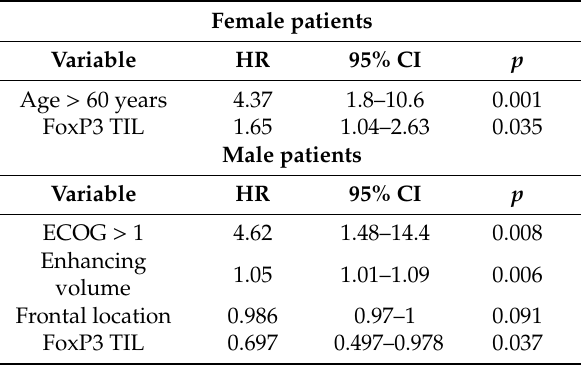
Figure 3. Selected Kaplan–Meier survival plots for variables with differential prognostic associations in female (upper row) and male patients (lower row). ( A ) In female patients, CD45ro+ TIL were associated with a worse survival (mOS 5.3 vs. 18.2 months, p = 0.027). ( B ) In contrast, there is no significant association in male patients (mOS 37.7 vs. 9.95 months, p = 0.25). ( C ) In female patients, FoxP3+ TILs are associated with worse survival (mOS 9.6 months vs. mOS not reached, p = 0.049), whereas in males ( D ) there is no association (mOS 49.6 vs. 11.8 months, p = 0.16). ( E ) While increased enhancing tumor volume does not affect survival in females (mOS 16.8 vs. 7.1 months, p = 0.23), male patients ( F ) with an increased contrast enhancement show a non-significant tendency towards worse outcomes (6.92 vs. 37.7 months, p = 0.09). ( G ) Cluster membership was associated with survival in female patients (mOS 3.9 vs. 18.2 vs. 82.9 months, p = 0.005, ( H ) but not in male patients (37.7 vs. 11.8 months, p = 0.17). Table 2. Cox regression modelling performed separately for female and male patients. Hazard ratios for numerical variables are given as per percentage point increase (FoxP3, frontal location) and per cm 3 increase (enhancing